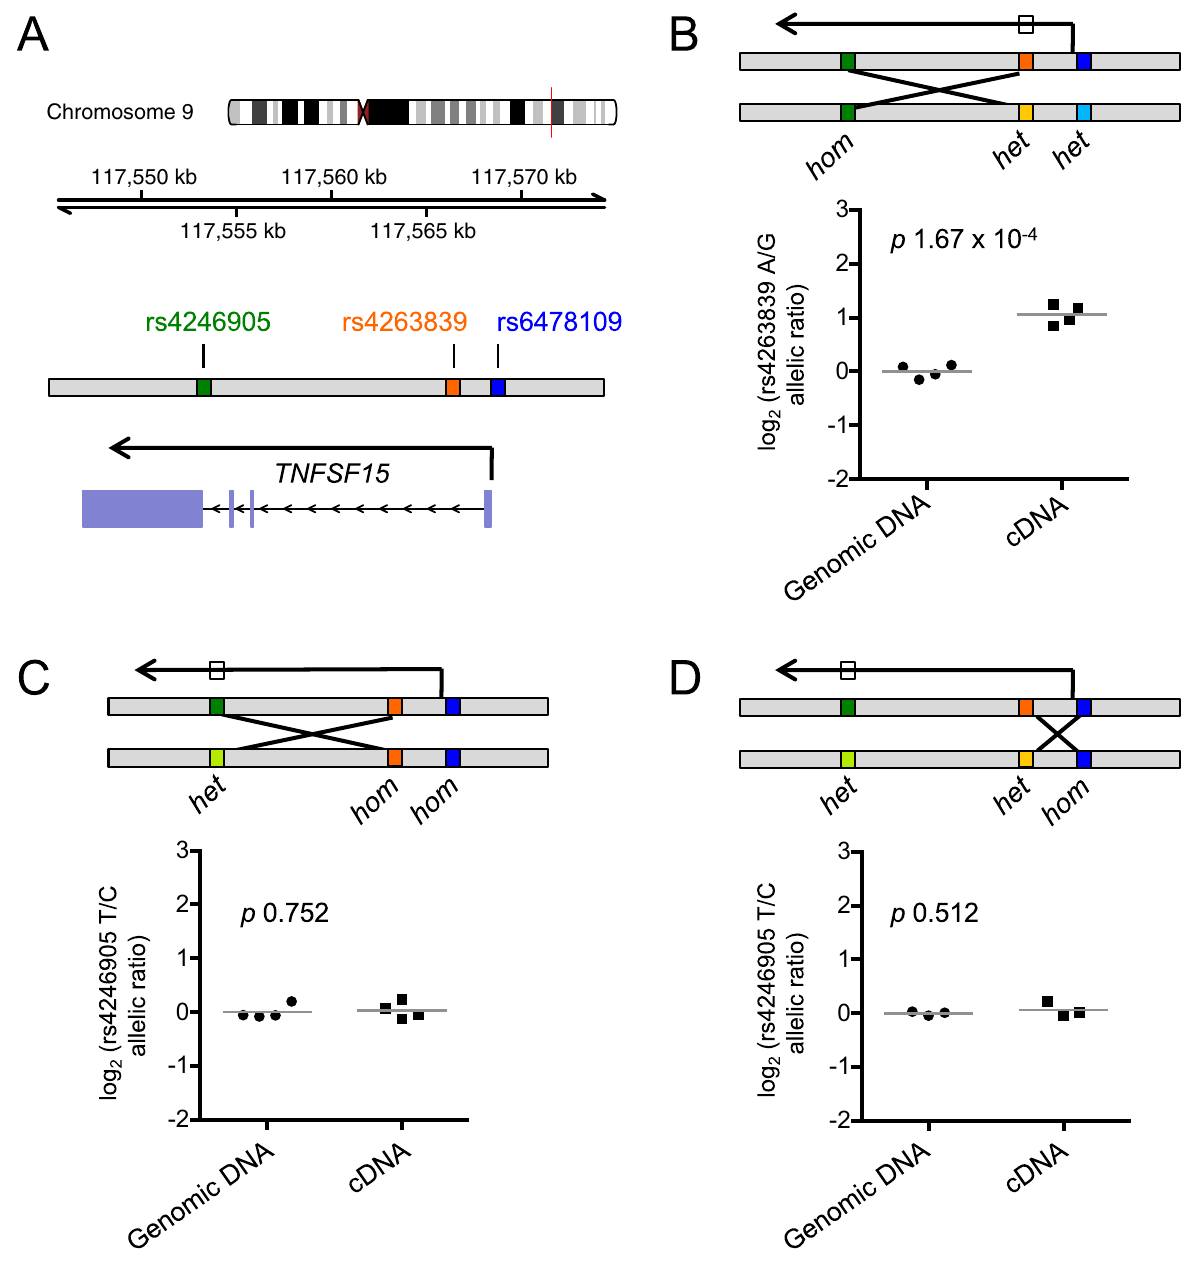
Fig 4. The eQTL causal SNP resides upstream of TNFSF15 . ( A ) The TNFSF15 locus on chromosome 9 is depicted, marking SNPs used for functional fine-mapping. ( B ) Immune complex-stimulated monocytes from individuals heterozygous at rs6478109 and rs4263839 but homozygous at rs4246905 (n = 4) were examined for allele-specific expression. The box on the transcription arrow indicates the SNP used for measuring allelic imbalance. ( C ) As (B) with individuals homozygous at rs6478109 and rs4263839 but heterozygous at rs4246905 (n = 4). ( D ) As (B) with individuals homozygous at rs6478109 but heterozygous at rs4263839 and rs4246905 (n = 3). Lines represent mean values and p values are from Welch’s